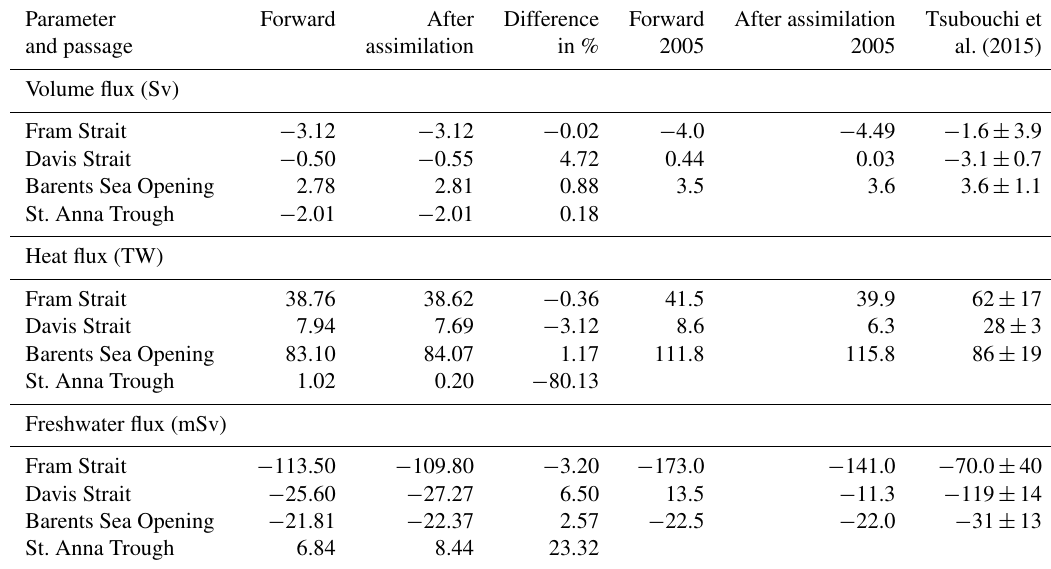
Table 2. Mean values of different fluxes through Arctic Ocean passages. Parameter Forward After Difference Forward After assimilation Tsubouchi et and passage assimilation in % 2005 Volume flux